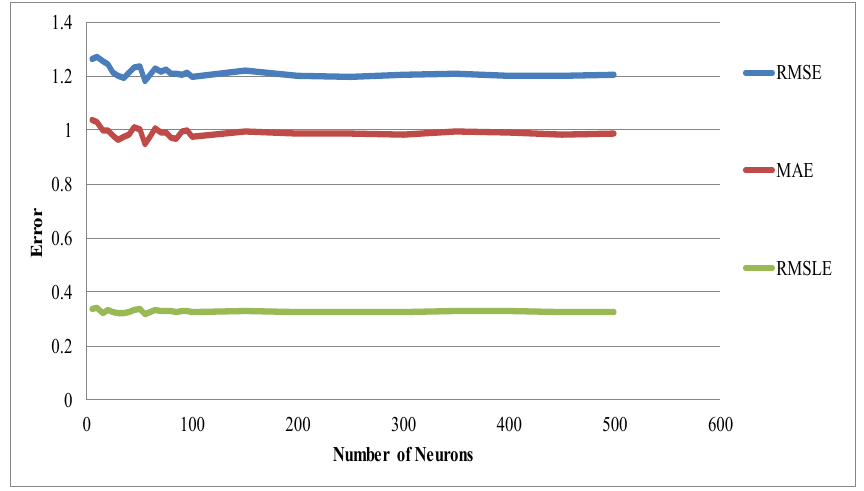
Figure 9. Table showing the number of neurons for the range of 0 – 1000 against error metrics (RMSE, MAE, and RMSLE) for one hidden layer in the validation group. The three metrics are average values.